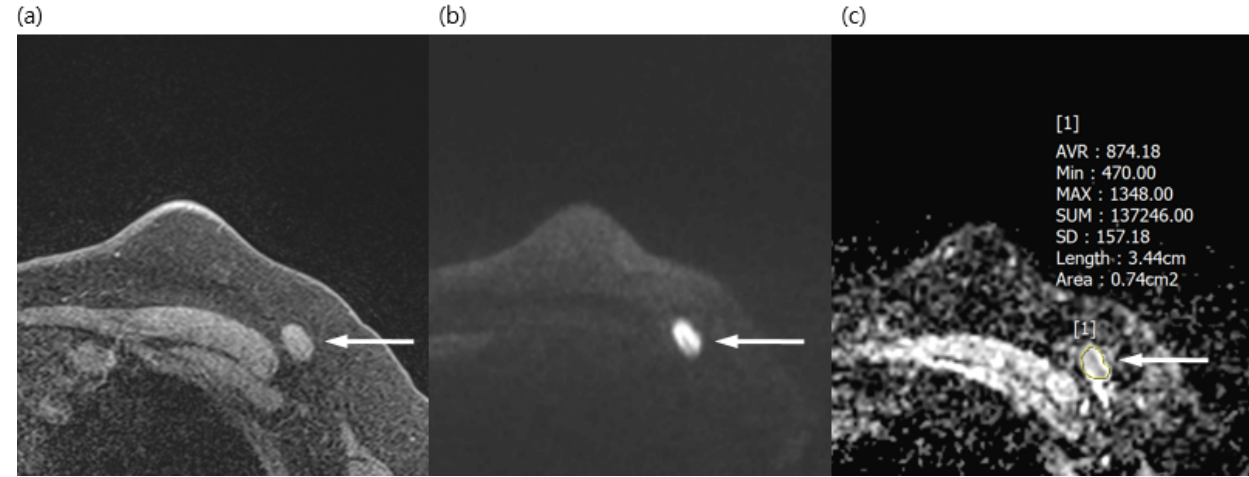
Figure 1. A 50-year-old woman with a surgically verified metastatic lymph node in left axilla level I. ( a) Axial pre-contrast T1WI of the left axilla shows a 1.5 cm lymph node with loss of fatty hilum (arrow). ( b) Axial DWI (b values, 1000 mm 2 /s) shows a lymph node (arrow) as an area of high signal intensity. ( c) Axial ADC map (b values, 1000mm 2 /s) shows the same lesion with restricted diffusion (arrow). The region of interest was manually drawn on the ADC map, guided by pre-contrast T1WI to avoid the fatty hilum. The mean ADC of the lesion was 0.874 × 10 − 3 , which indicated a metastatic lymph node.